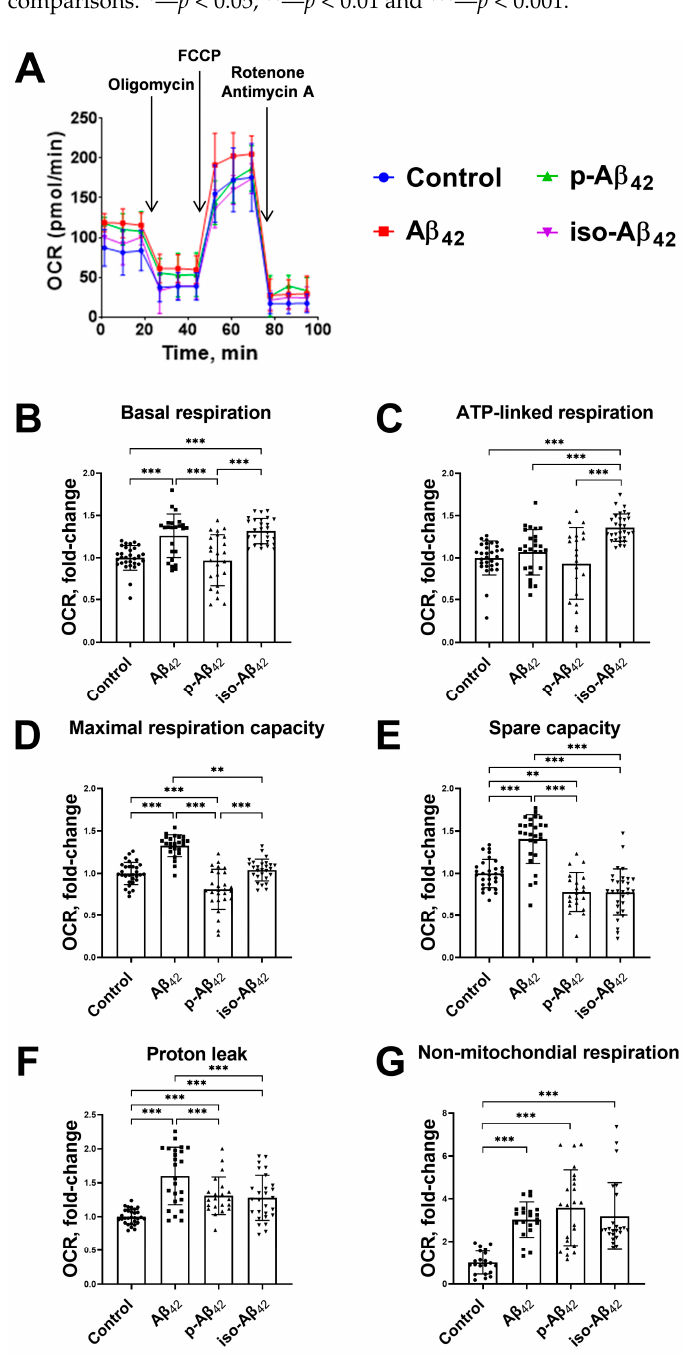
Figure 7. The effects of beta-amyloid isoforms on the bioenergetic functions in bEnd.3 cells after 24 h incubation. Cells were incubated with 10 µ M of A β 42 , p-A β 42 and iso-A β 42 . ( A ) Representative raw data of bioenergetic function. ( B ) Basal respiration, ( C ) ATP-linked respiration, ( D ) maximal respiration capacity, ( E ) spare capacity, ( F ) proton leak and ( G ) non-mitochondrial respiration are demonstrated. The results were calculated based on the data obtained from bioenergetic functional analysis (for details, see Figure 5). The values in the control samples were taken as 1. All parameters given are normalized to control. OCR is the oxygen consumption rate. FCCP is carbonyl cyanide 4-(trifluoromethoxy)phenylhydrazone. Each geometric figure (circle/square/up-pointing trian- gle/down-pointing triangle) in the histogram represents the result in an independent sample and corresponds to the Control, A β 42 , p-A β 42 and iso-A β 42 . The mean ± SD in 3 independent experi- ments in 5–8 replications is shown in the figure. The statistical difference between experimental groups was analyzed by one-way analysis of variance using the post hoc Tukey test for multiple comparisons. **— p < 0.01 and ***— p < 0.001.